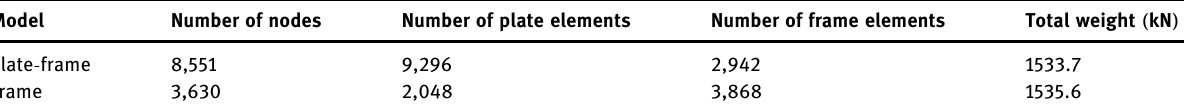
Table 2: Information about the developed